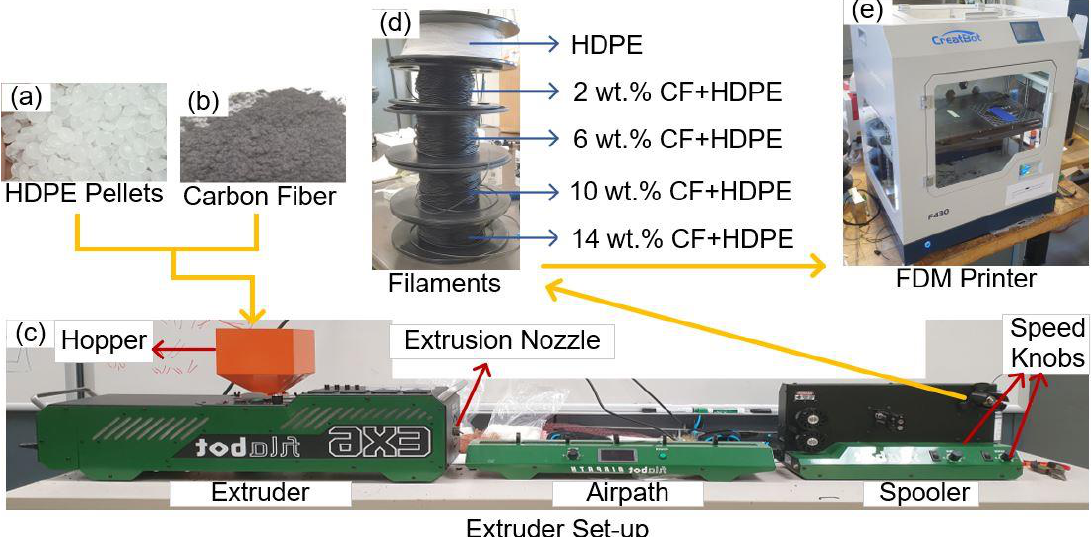
Figure 2. Experimental setup: filament preparation and FDM process. ( a ) HEPE pellets, ( b ) Carbon fiber, ( c ) extruder set-up, ( d ) filaments of CF+HDPE with different CF contents, and ( e ) a picture of the PDM printer used in this investigation. Table 2. Process parameters of the FDM